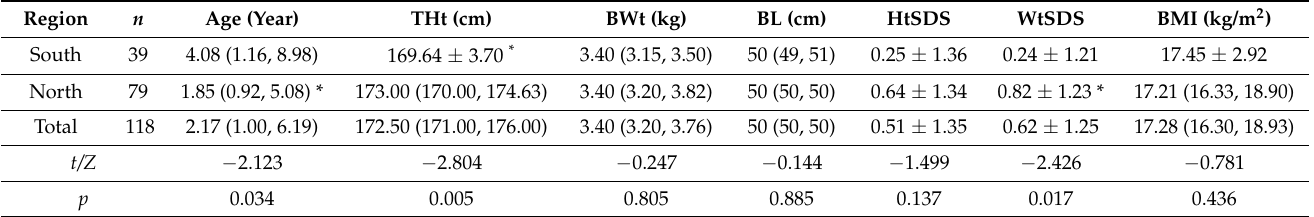
Table 1. Clinical parameters of children with AIS in the northern and southern regions of